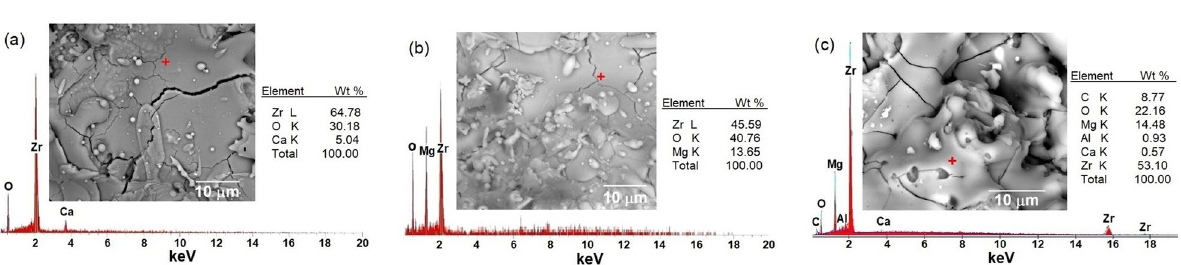
Figure 5. EDX spectra of the as-sprayed top coatings showing elements composition: ( a ) ZC3, ( b ) ZM3, and ( c ) Mix3. SEM images and table of elements (in wt%) are shown for the examined samples. The spots where EDX were performed are represented as cross mark on the corresponding SEM images. Coatings were performed on the 304 stainless steel substrate at plasma current of 700